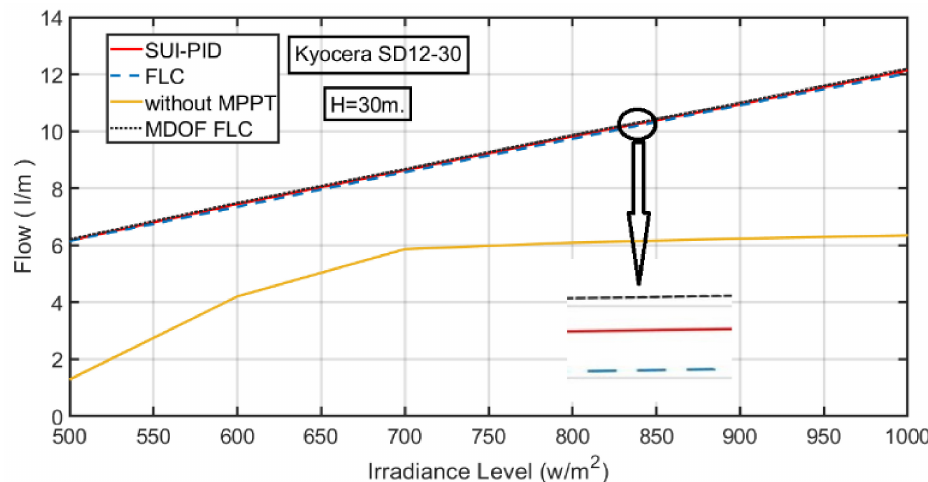
Figure 20. Performance analysis of the volume flow rate at a head of 30 m.